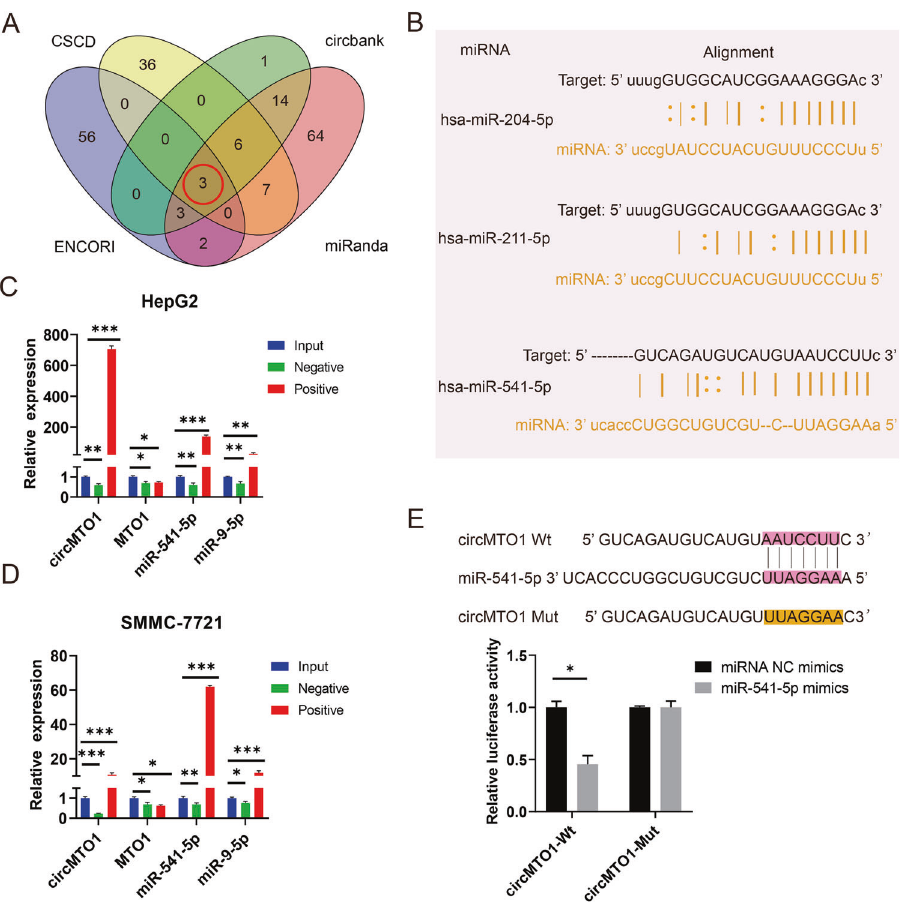
Fig. 2 miR-541-5p was regulated by circMTO1. A The intersected miRNAs were predicted from the four databases. B ENCORI database- predicted sites through which miRNAs bind to circMTO1. C , D Pull-down assays were performed using circMTO1 probes in HepG2 and SMMC- 7721 cells, and circMTO1, linear MTO1, and miRNAs enrichment was detected using RT-qPCR. E HEK293T cells were co-transfected with miR- 541-5p mimics and Wt or Mut circMTO1 luciferase reporter vectors, and luciferase reporter activity was detected. Data were presented as mean ± SD of three independent experiments. * P < 0.05, ** P < 0.01, *** P <